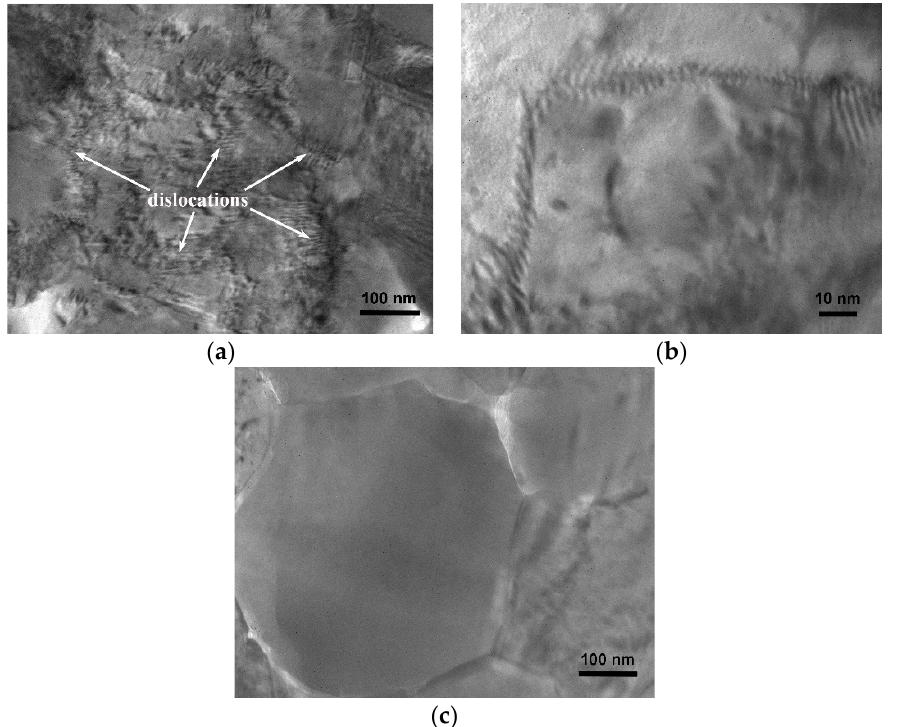
Figure 9. TEM images of samples prepared by ( a , b ) HOP and ( c ) HP at 550